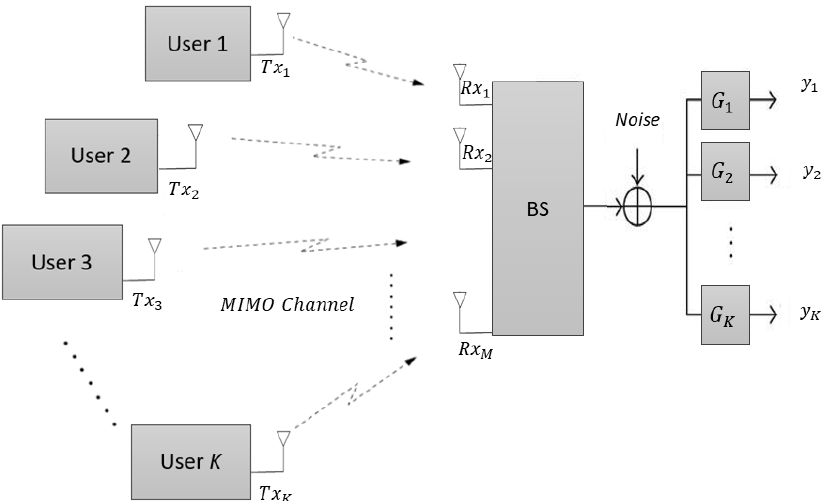
Figure 2. MU-MIMO uplink system with K users each with a single antenna and a BS with Rx M receive